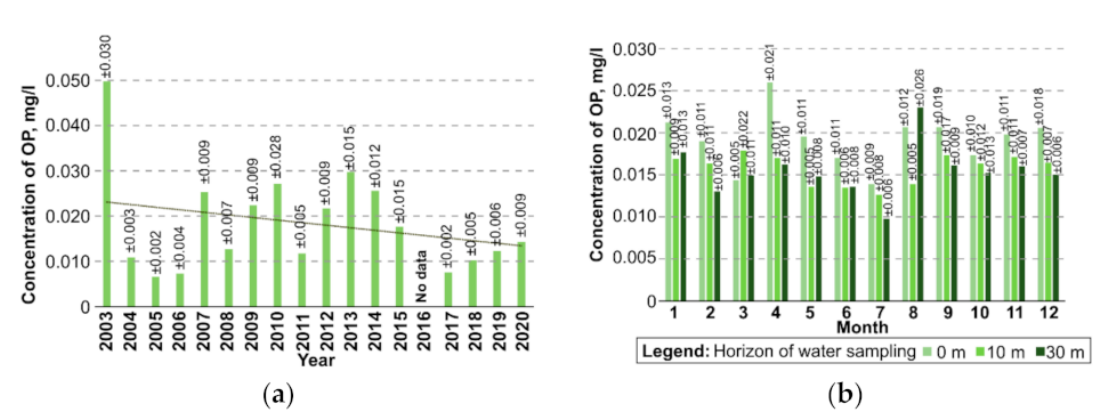
Figure 12. Interannual variability of the average concentration of oil products in the water column at the D-6 oil platform ( a ) and seasonal variability of the concentration of oil products averaged over the months from 2011 to 2020 for layers of 0, 10, and 30 m ( b ). The numbers above the columns indicate the mean squared